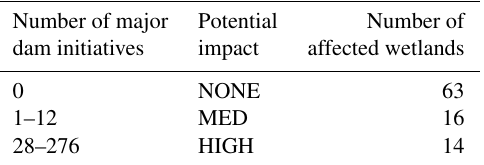
Table 2. Defined impact on a riparian wetland due to new dam ini- tiatives in the upstream